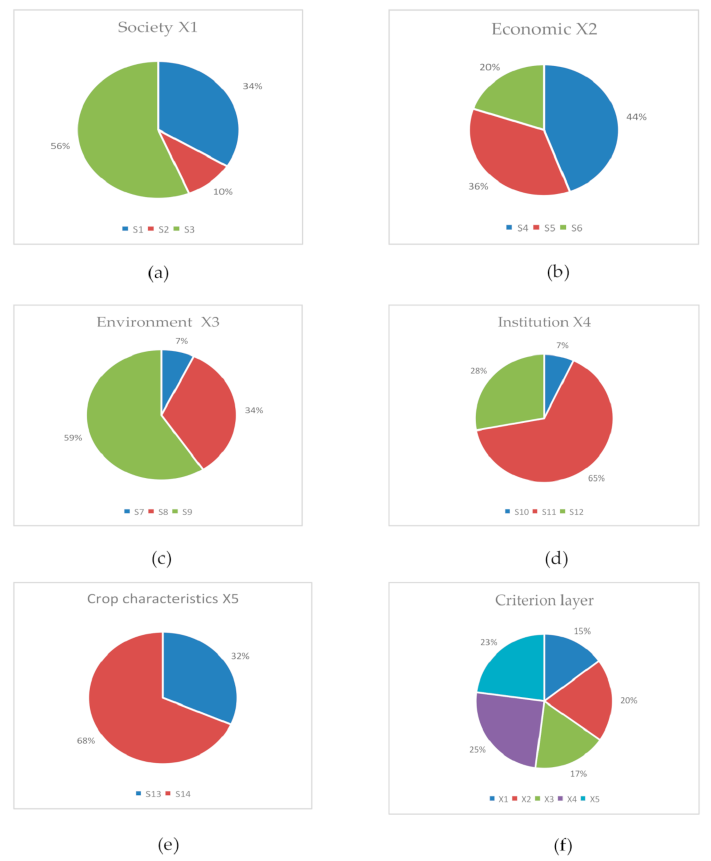
Figure 8. The weight ratio of influencing factors of each dimension. ( a ) Social dimension; ( b ) economy dimension; ( c ) environment dimension; ( d ) institution dimension; ( e ) crop characteristics dimension; ( f ) criterion layer